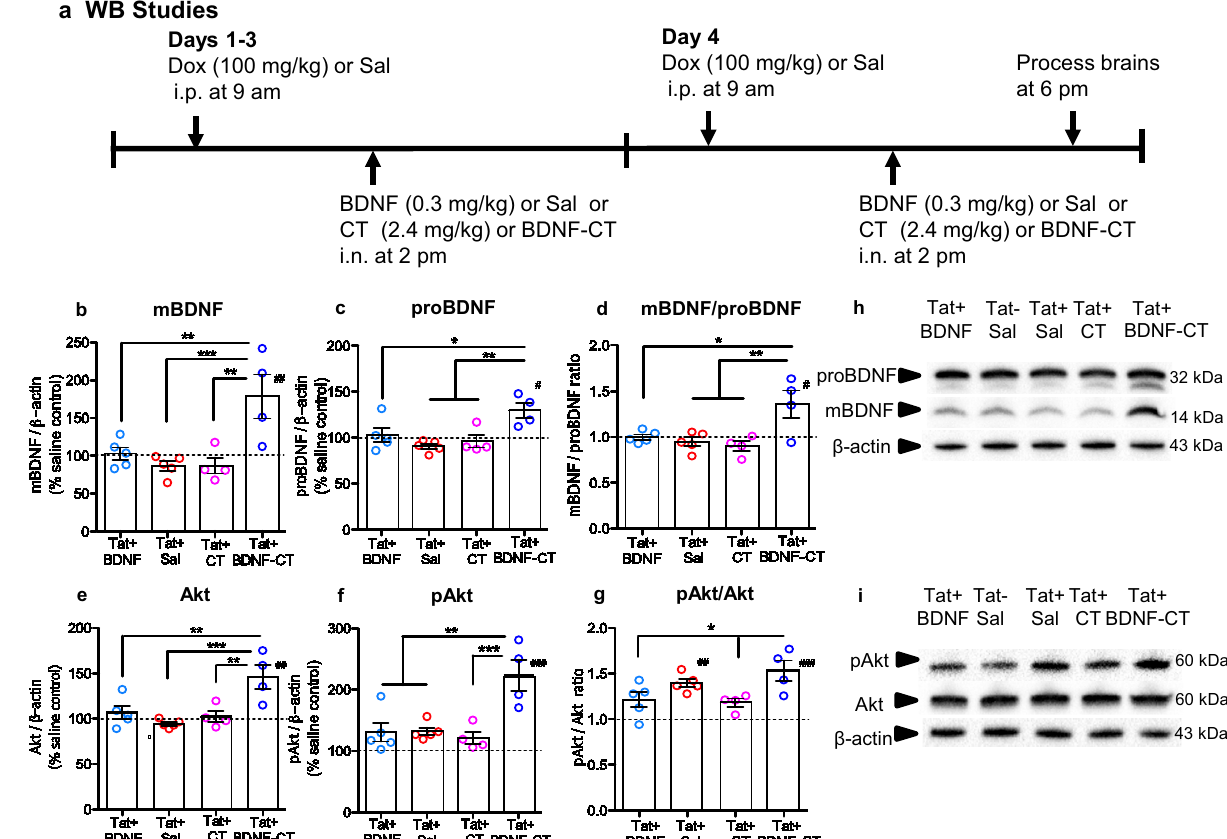
Fig. 3 CT are required for BDNF delivery to the hippocampus and increased Akt expression and signaling. Tat + mice received i.p. Dox and one of four i.n. treatments (BDNF, Sal, CT, or BDNF-CT) daily for 4 days ( a ). Global control (Tat − ) mice received i.p. and i.n. saline (Tat-/Sal). The hippocampal tissue shows increased mBDNF ( b ), proBDNF ( c ), mBDNF/proBDNF ratio ( d ), Akt ( e ), pAkt ( f ), and the pAkt/Akt ratio ( g ) in Tat + mice that received BDNF-CT vs. other treatments (* P <0.05, ** P <0.01 and *** P <0.001), as well as vs. saline treated Tat- mice ( # P <0.05 and ## P <0.01, ### P <0.001) . Tat + mice treated with BDNF-CT or Sal had higher pAkt/Akt ratios ( g ) compared to Tat- controls but levels of Akt and pAkt were signi fi cantly higher in BDNF-CT vs. Sal treated Tat + mice indicating enhanced Akt expression and signaling only with BDNF-CT NPs. Representative WB images are shown ( h , i ). Data are shown as the mean % change from Tat- control (Tat-/Sal) represented by dotted lines ( n = 4 – 5 per group, fi ve cohorts were processed in parallel). Error bars represent protein kinase B (pAkt) levels ( F (4, 18) = 11.72, P < 0.0001, n = 4 – 5/ group; Fig. 3f). pAkt levels were higher in Tat + mice treated with BDNF-CT compared to saline ( P < 0.01), CT alone ( P < 0.001) and